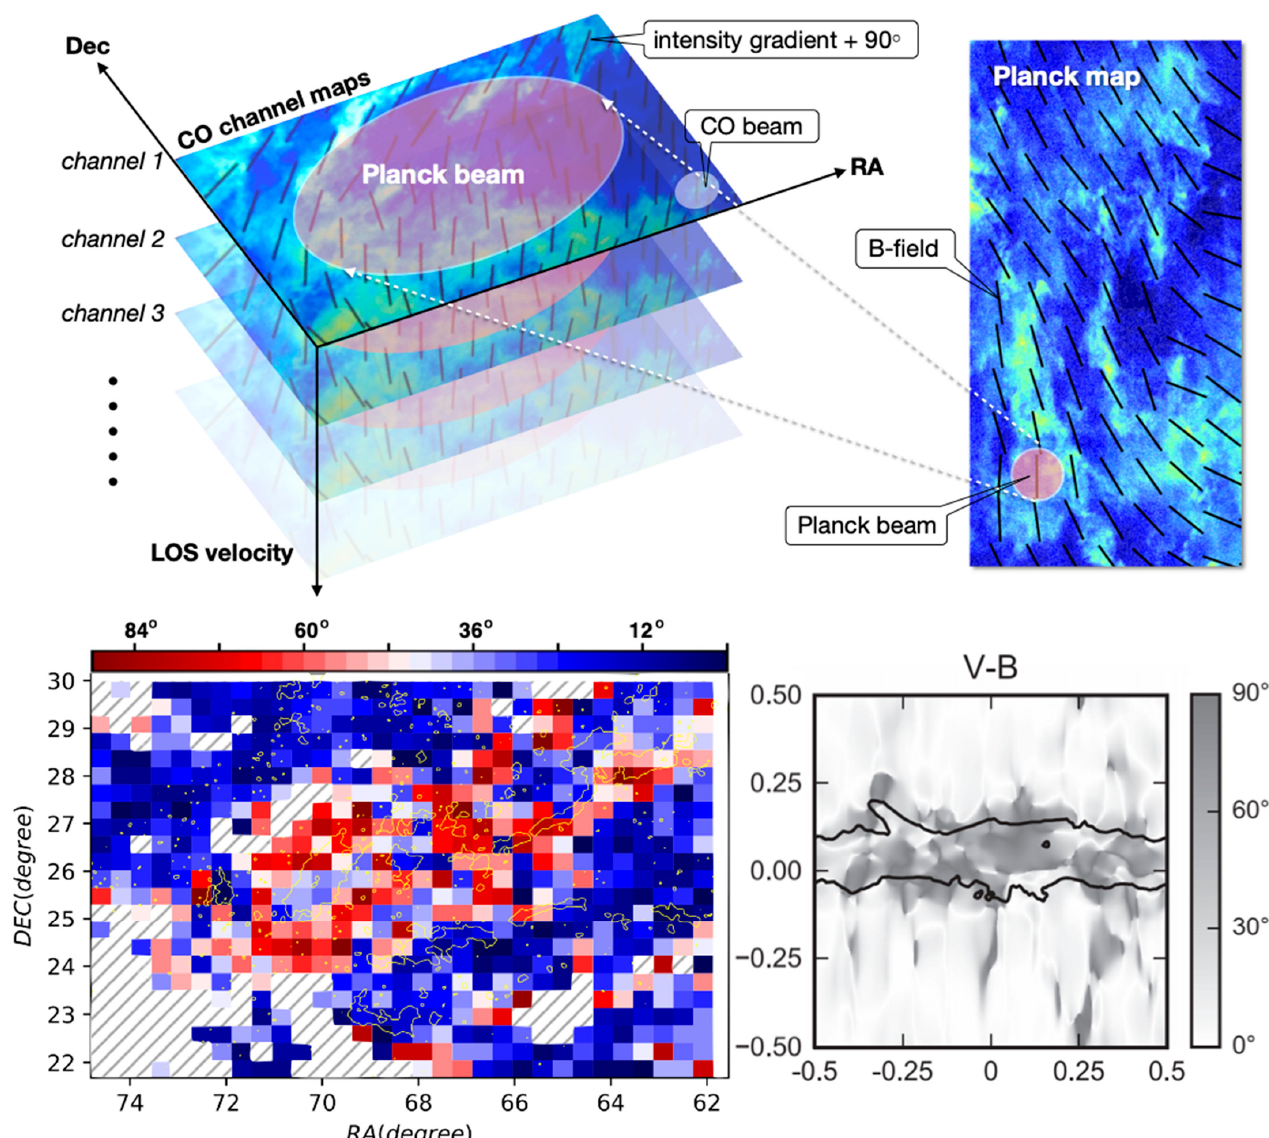
Figure 11. Velocity anisotropy in Taurus molecular cloud (TMC). ( Upper panel ) The method for detecting velocity anisotropy [40]. The intensity gradient of each CO velocity channel map is turned 90 degrees, in order to indicate the direction of velocity anisotropy. All the anisotropy directions covered by one Planck beam are averaged and weighted by intensity using the Stokes parameters (see Section 4.1), in order to compare with the B-field directions inferred from the Planck data. ( Lower-left ) The difference between B-field and velocity anisotropy directions. The yellow contours indicate the column density where the PDF inferred from the extinction data changes from log-normal to power-law [33]. The color code is for the directional difference between B-fields and velocity anisotropy. The red region (large directional difference) is coincident with the high-density region which is ~75 ◦ from the B-field (see Taurus in Figure 9). The striped areas are too noisy to conclude. ( Lower-right ) Similar to the left panel but from one of the MHD simulations of [38]. They simulate slightly magnetic critical clouds with sub- to trans-Alfv é nic turbulence. The contour shows the mean column density. The result is very similar to what was observed from Taurus—the directional offsets between velocity anisotropy and B-fields are small along LOS of low column densities but approaching perpendicularity as column density